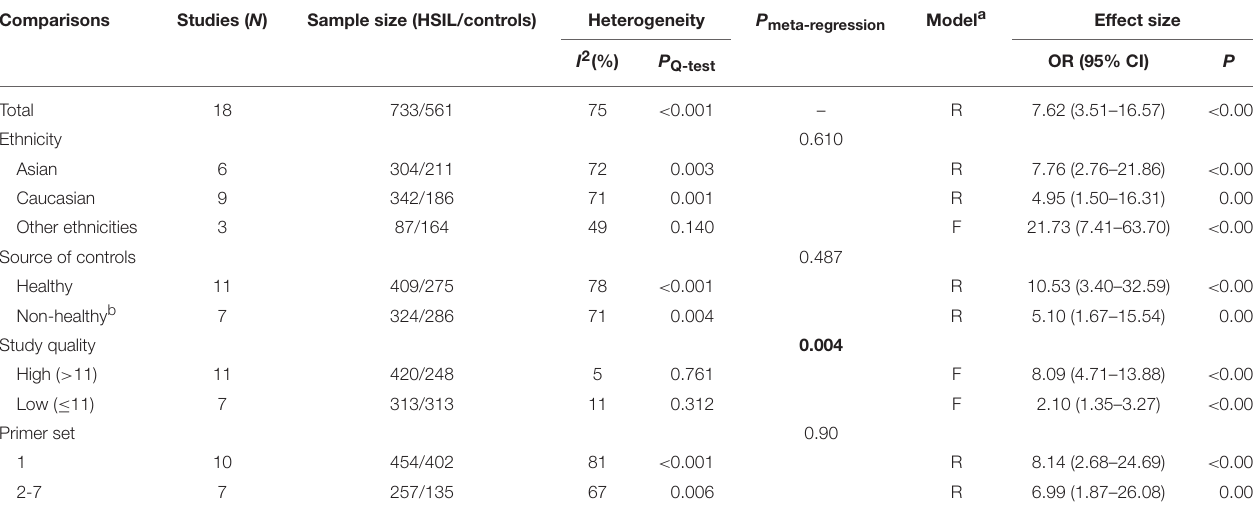
TABLE 3 | Pooled results for the association of DAPK1 promoter hypermethylation with HSIL risk.